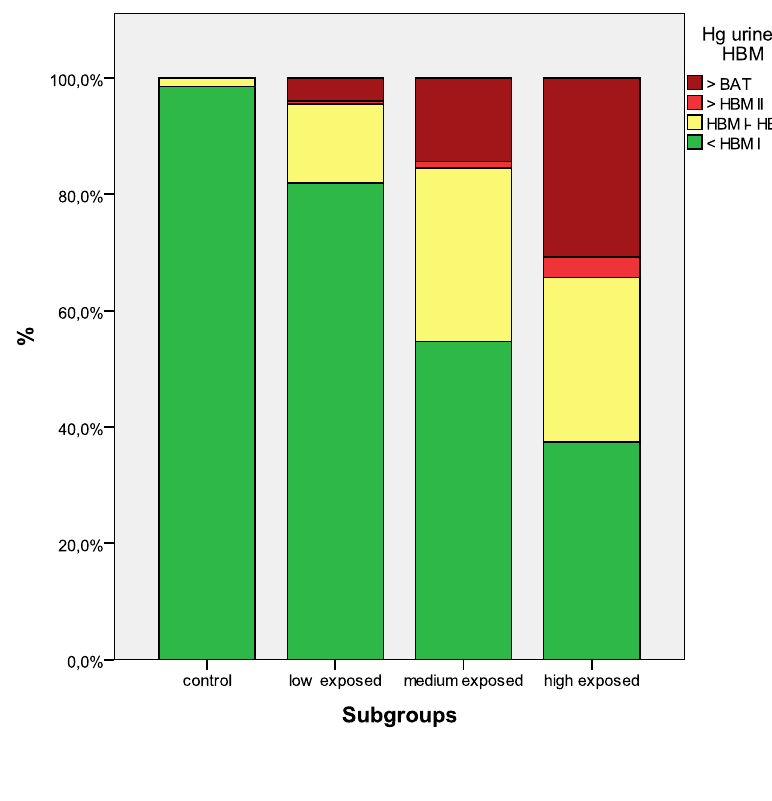
Figure 5. Mercury in urine—stacked bar chart for threshold